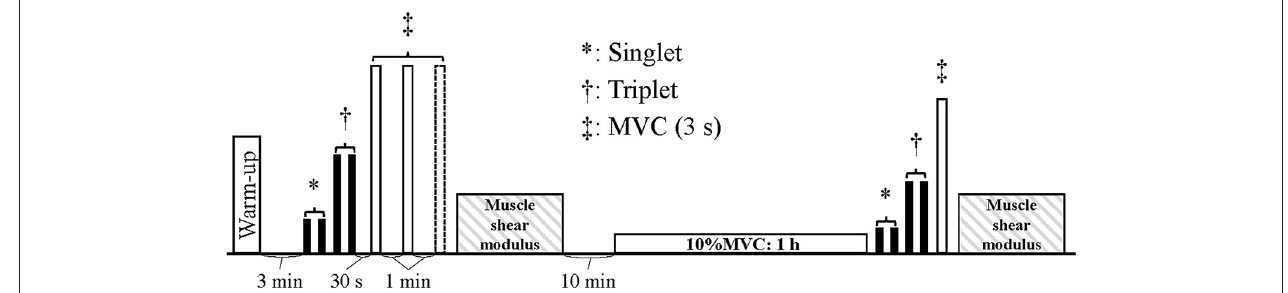
FIGURE 1 | Experimental procedures. MVC, maximal voluntary contraction of isometric plantar flexion.